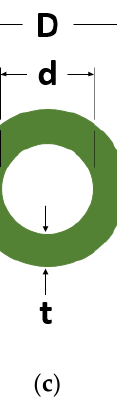
Figure 4. ( a ) Plot of slenderness ratio vs. load; ( b ) schematic representation of an isolated nanotube; ( c ) outer diameter D and inner diameter d of MWCNT.